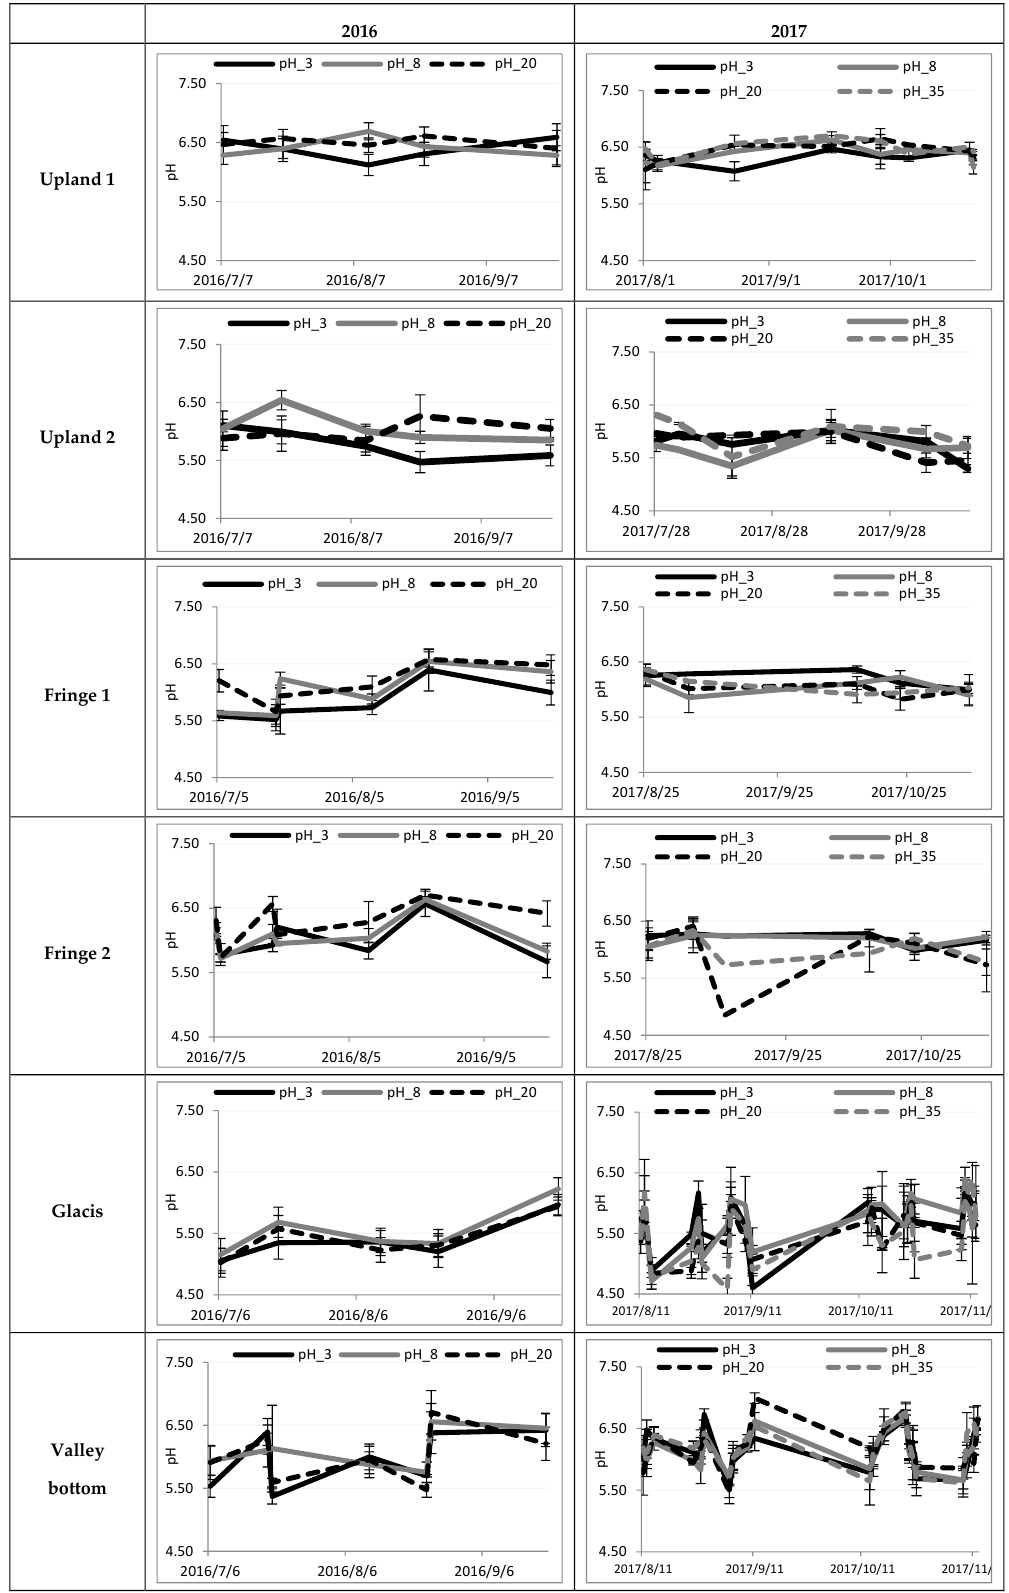
Figure 7. Soil pH at di ff erent soil depths during the 2016 and 2017 growing seasons. Error bars indicate the standard errors of the